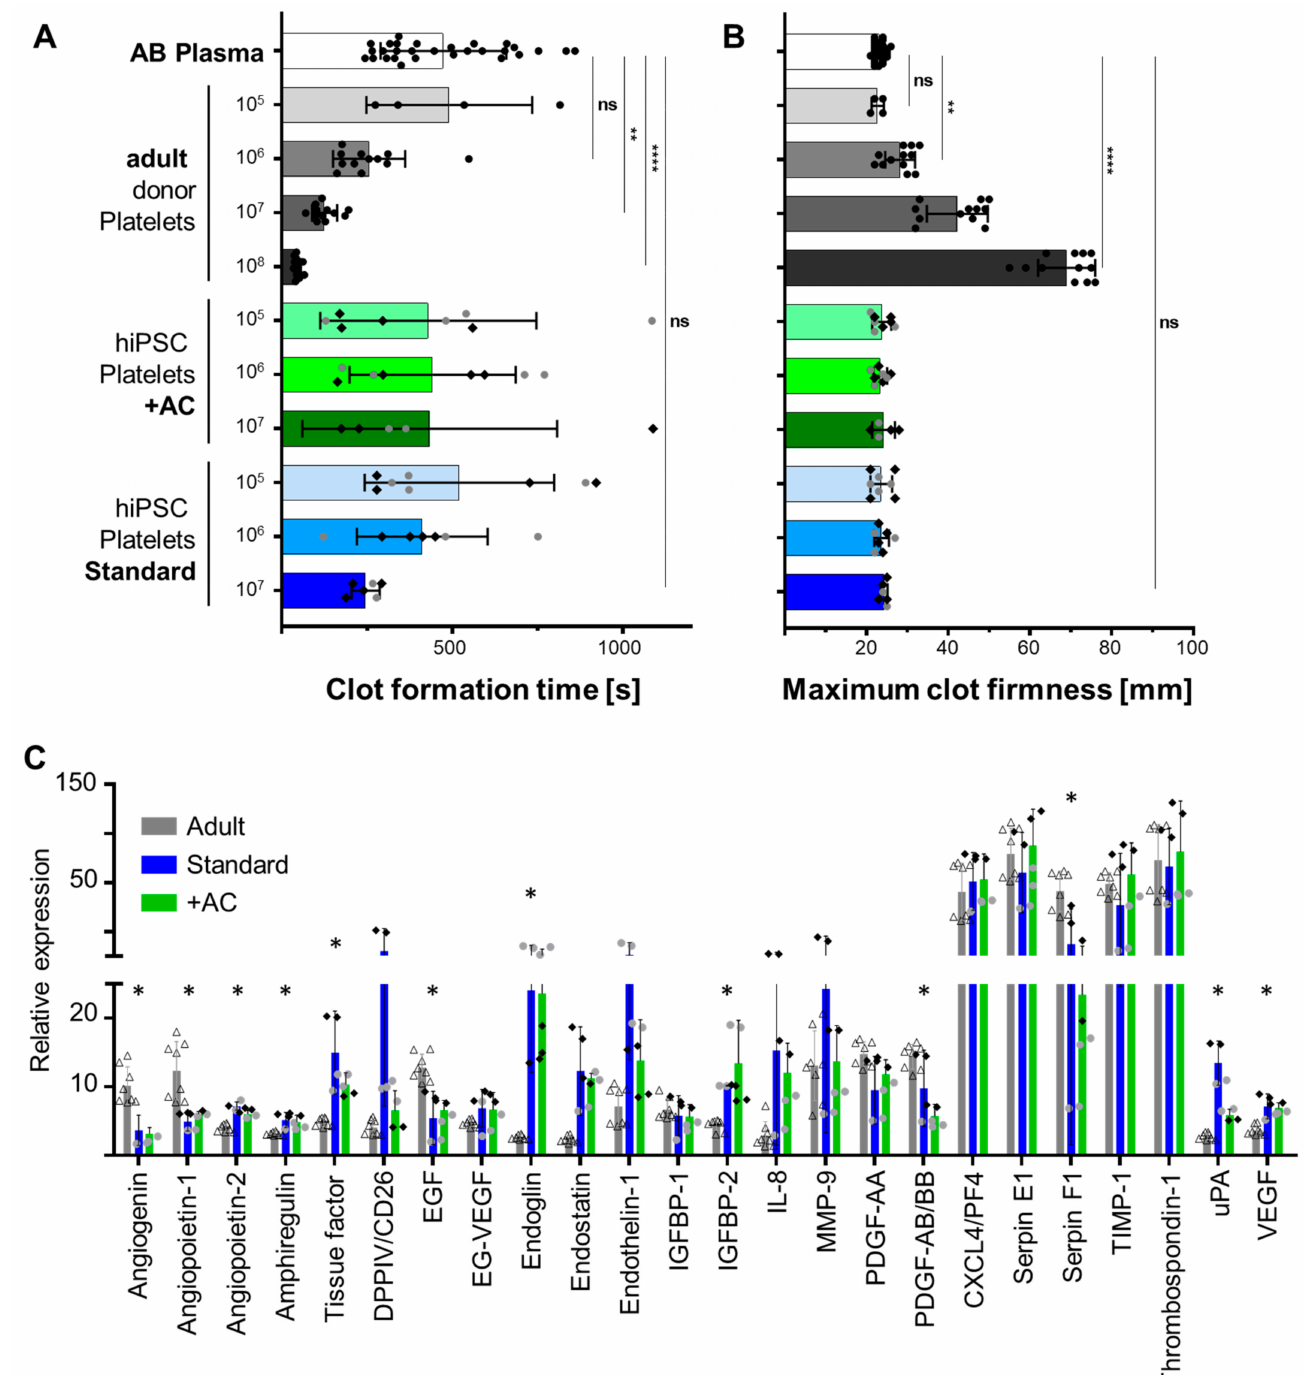
Figure 5. Analysis of coagulation and angiogenesis-related protein expression in adult healthy donor- and hiPSC-derived platelets. ( A , B ) Clot formation potential of standard culture vs. improved (+AC) hiPSC-derived platelets was compared to adult donor-derived platelets using rotational thromboelastometry ( n = 4–12 platelet samples as indicated by individual result icons; n = 28 control plasma tests of the same AB plasma pool illustrating individual variability; hiPSC platelets derived from clones UCB144-CT2-C, grey circles and BIHi001-A, black diamonds; two-way ANOVA, multiple comparisons, ** p < 0.01 and **** p < 0.0001; ns, not significant). ( A ) Clot formation time induced by adding increasing numbers of platelets as indicated to 300 µ L AB plasma control. ( B ) Maximum clot firmness in the absence (AB plasma) or presence of increasing number of platelets as indicated. Analysis was standardized to 2 × 10 7 input platelets per membrane and measured in duplicate spots. ( C ) Several angiogenesis-related proteins were significantly increased (angiopoietin 2, p <